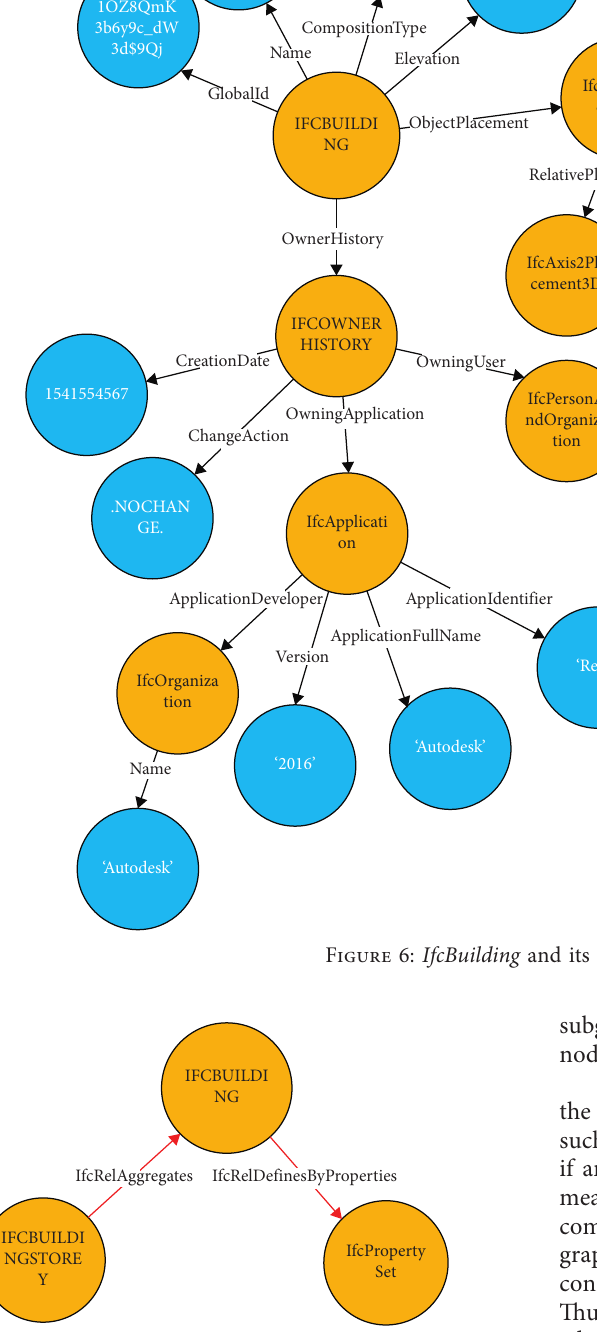
Figure 7: Graph after transformation. The maximum common subgraph is shown in Figure 9(c). When traversing to the entity node, its attribute node set will be mined through the previous method. The